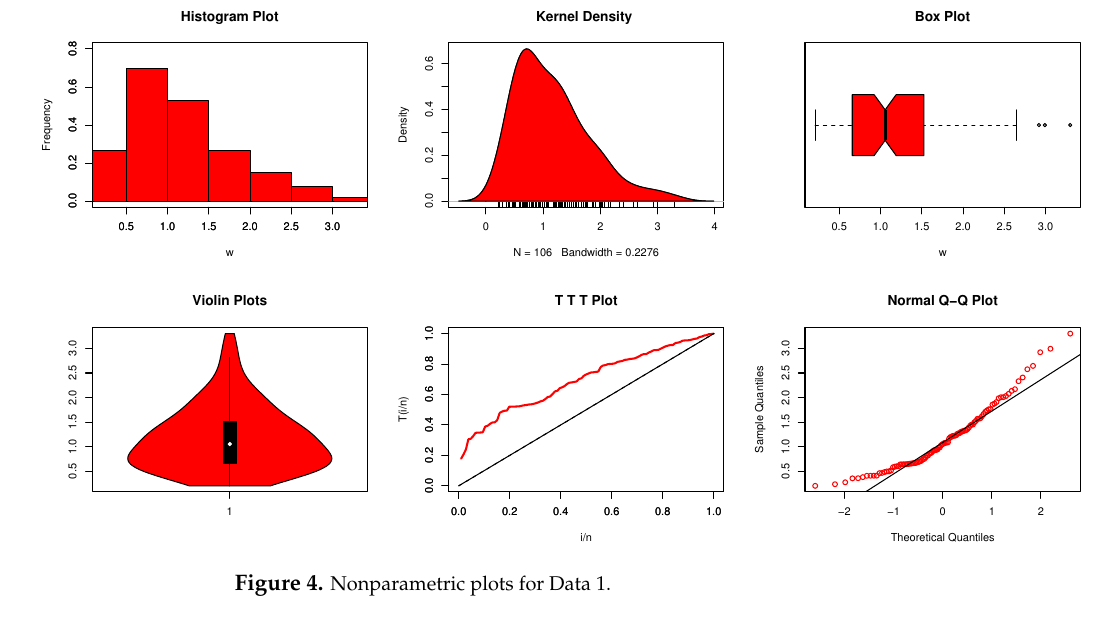
Figure 4. Nonparametric plots for Data 1.